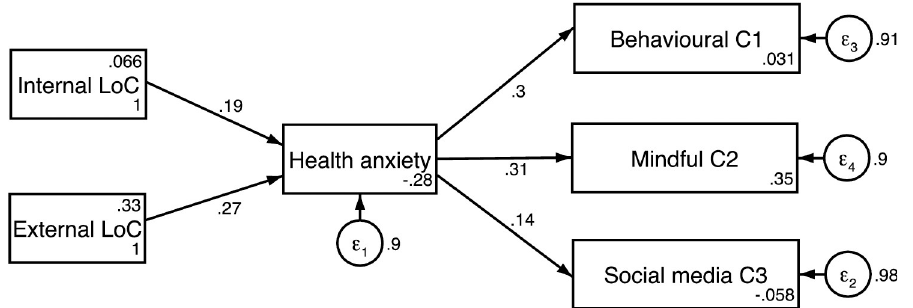
Fig 4. Structured path model for 46 years and